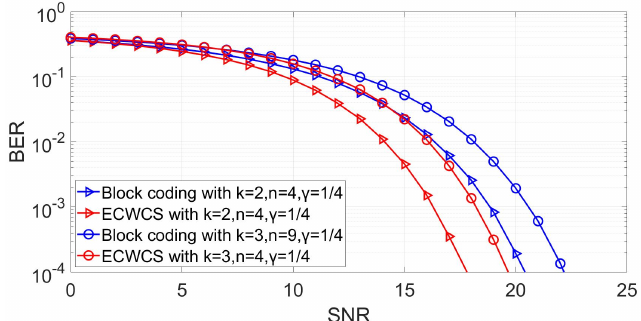
Figure 3. Error performance of the block coding scheme and the ECWCS